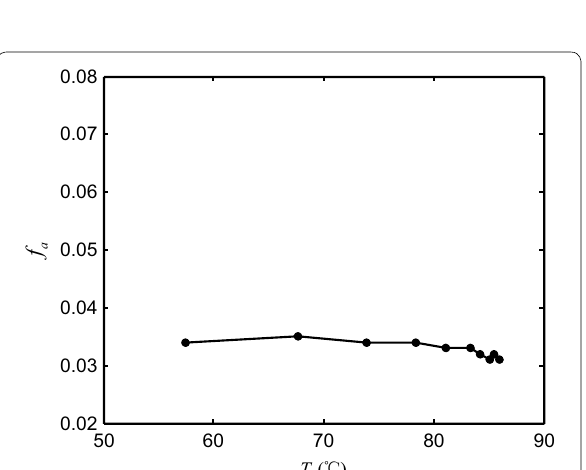
Figure 7 Variation of contact frictional coefficient